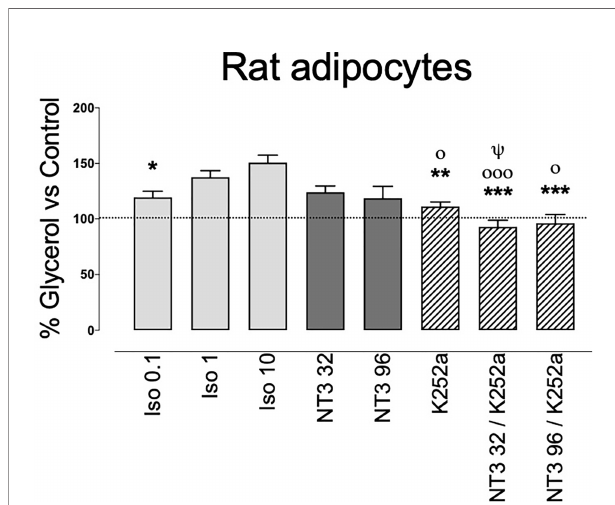
FIGURE 4 | Lipolytic activity of NT3, through activation of TrkC, in isolated rat adipocytes. Isoprenaline (0.1 µM, 1 µM, and 10 µM) or NT3 (32 and 96 ng ml − 1 ) increases glycerol levels in adipocytes isolated from rat abdominal white adipose tissue. The Trk inhibitor K252a (0.2 µM) inhibits NT3-induced increase in glycerol levels. Data are expressed as a percentage vs control and are the mean± SEM of n= 15 experiments. * P < 0.05, ** P < 0.01, *** P < 0.001 vs isoprenaline 10 µM, ο P < 0.05, οοο P < 0.001 vs isoprenaline 1 µM, y P < 0.05 vs NT3 32 ng ml − 1 , one-way ANOVA followed by Brown-Forsythe and Welch